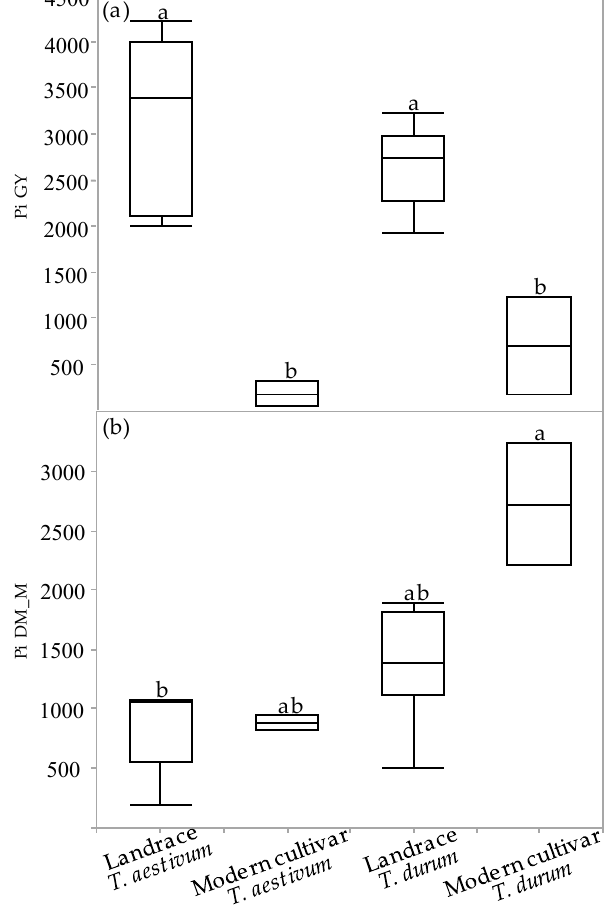
Figure 5. Superiority index (Pi) of genotypic groups across environments: Pi for grain yield ( a ) and dry matter biomass accumulation at maturity ( b ). Different letters indicate significant differences between genotypic groups using Tukey–Kramer’s test ( p ≤ 0.05).